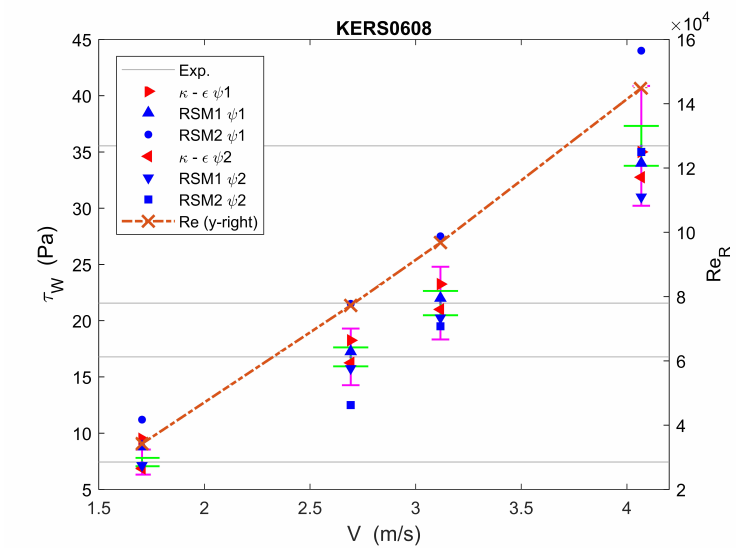
Figure 13. τ y = 1.88 Pa, m = 0.0102 Pas n , n = 0.8428 and D = 79